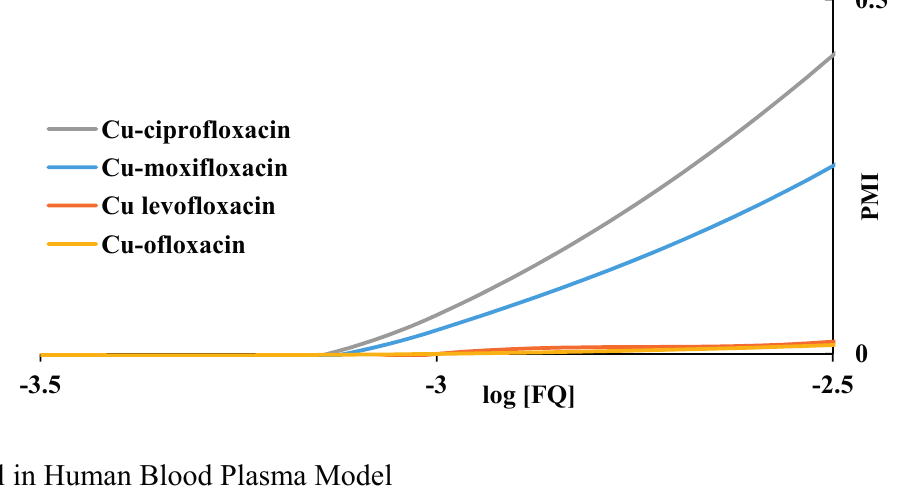
Figure 13. The effect of fluoroquinolone ligands on plasma mobilization of